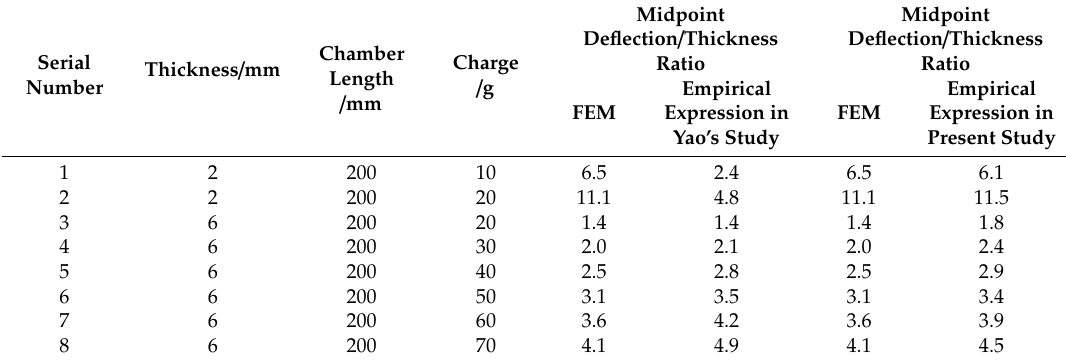
Table 5. Comparison of the predicted midpoint deflections of the 2 mm and 6 mm target